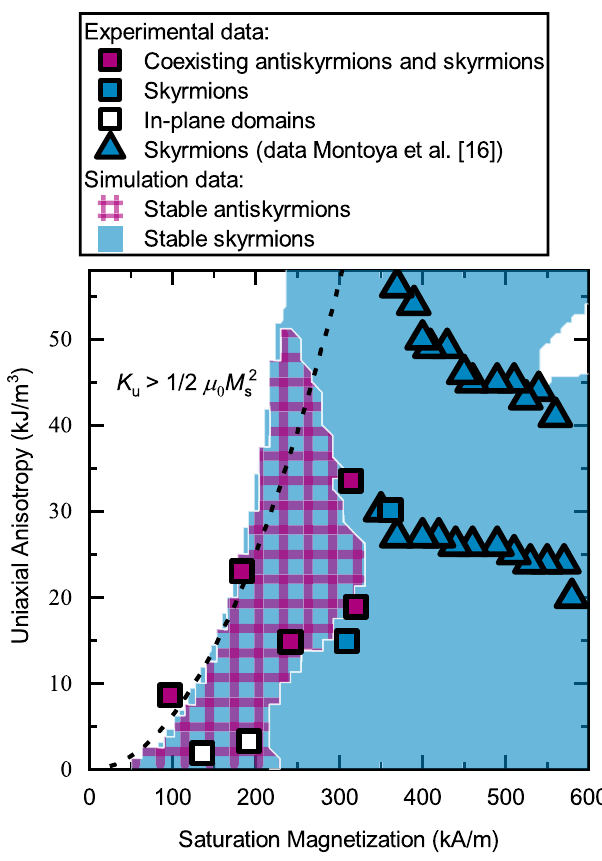
Fig. 6 Phase diagram of antiskyrmions and skyrmions. The diagram includes both experimental and simulation results, depending on the uniaxial magnetic anisotropy and saturation magnetization. The squares correspond to LTEM measurements that show antiskyrmions and skyrmions coexisting (purple), solely skyrmions (blue), and no visible spin objects (white) and their K u and M s values at the measured temperature. The triangles are experimental data points reported by Montoya et al. 16 obtained for similar Fe/Gd systems that show exclusively skyrmions. The colored areas of the diagram correspond to the parameter regions in which skyrmions (blue) and antiskyrmions (purple) are stable in our simulations. In the white regions, neither of them are stable. The dashed line shows K ¼ 1 μ M 2 u s 0 2 coexisted with skyrmions and sometimes with bubbles. Blue and white squares correspond to the existence of sole skyrmions and in-plane domains without further spin objects, respectively. Fig- ure 6 reveals the importance of low saturation magnetization μ M 2 > K for stabilizing values satisfying the condition 1 u s 0 2 antiskyrmions.